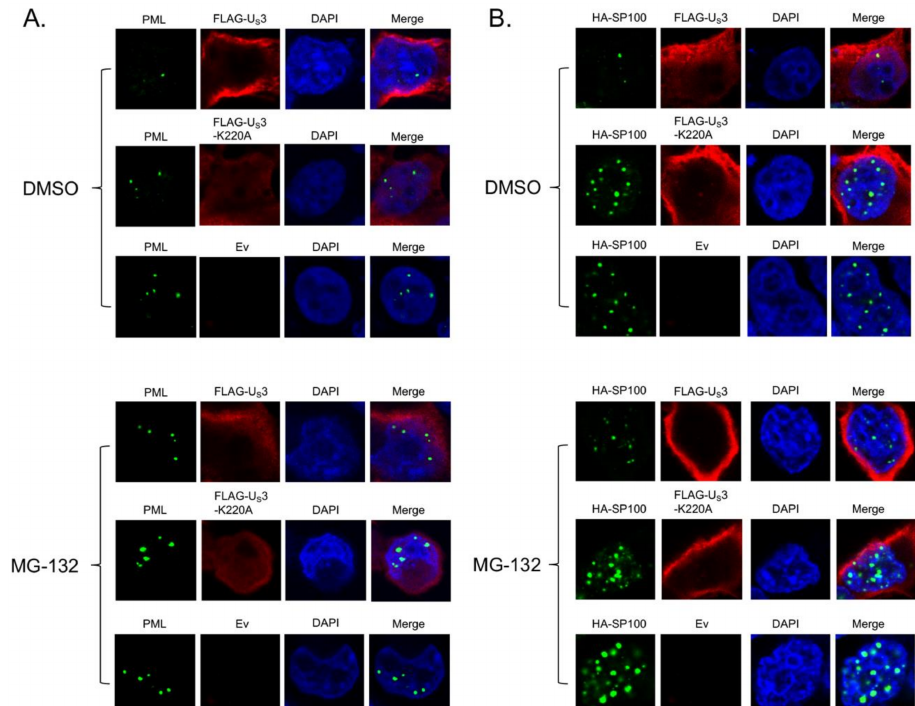
Figure 4. Effect of MG-132 treatment on MDV U S 3 induced disruption of PML and SP100. ( A ) 293 cells were transfected with pcDNA expressing FLAG-U S 3, FLAG-U S 3-K220A (kinase dead), or empty vector (Ev). Twenty-four hours later, cells were treated with DMSO or MG-132 (10 µ M) overnight. The next day, cells were fixed and permeabilized for immunofluorescence assay using primary mouse anti-PML antibody and rabbit anti-FLAG antibody, followed by secondary Alexa flour 488 conjugated goat anti-mouse antibody and Texas Red conjugated goat anti-rabbit antibody. ( B ) pcDNA expressing HA-SP100 was co-transfected with FLAG-U S 3, FLAG-U S 3-K220A, or Ev into 293 cells. Twenty-four hours later, cells were treated with DMSO or MG-132 (10 µ M) overnight. The next day, cells were fixed and permeabilized for immunofluorescence assay using primary mouse anti-HA antibody and rabbit anti-FLAG antibody, followed by secondary Alexa flour 488 conjugated goat anti-mouse antibody and Texas Red conjugated goat anti-rabbit antibody. DAPI was used to stain cell nuclei. All images were taken with a confocal microscope at the same magnification and representative images are presented. Scale bar = 10 µ